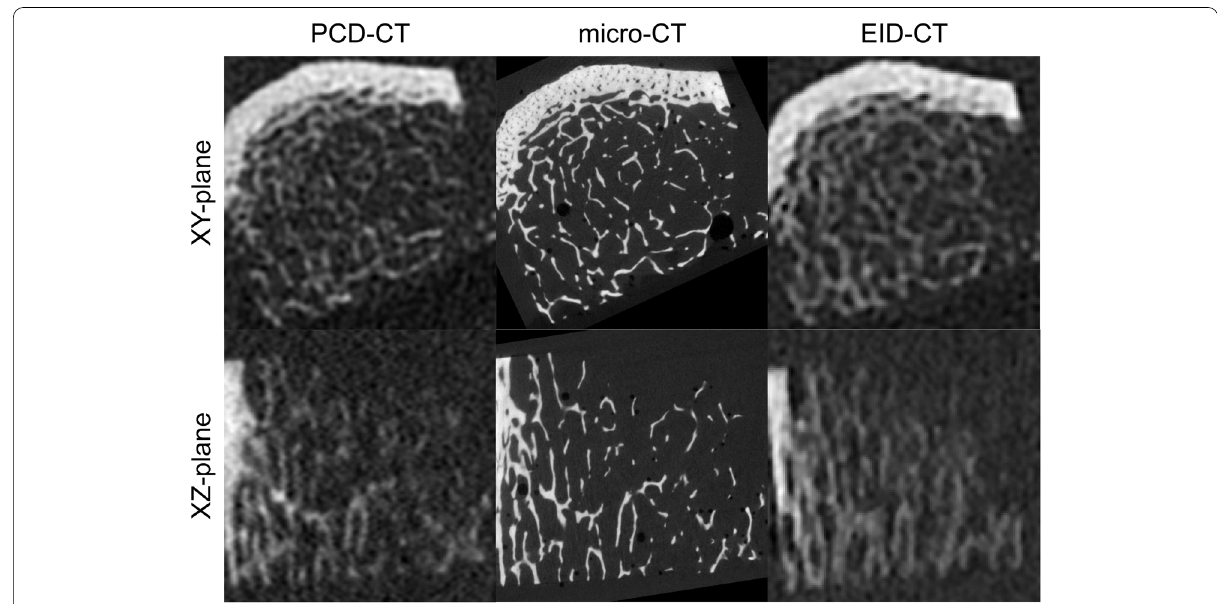
Fig. 2 Slices from the different devices used in the study in the xy -plane and xz -plane ( x horizontally in both planes). For the multislice computed tomography using photon-counting detectors (PCD-CT), the combination of a field of view of 51 mm and a matrix of 1,024 and for the multislice computed tomography using energy-integrating detectors (EID-CT) the mAs setting with the same CTDI vol as the PCD-CT was used. The PCD-CT and EID-CT slices are presented as they were scanned without any rotation applied, while the micro-CT has been registered to the PCD-CT volume. Micro-CT Micro-computed